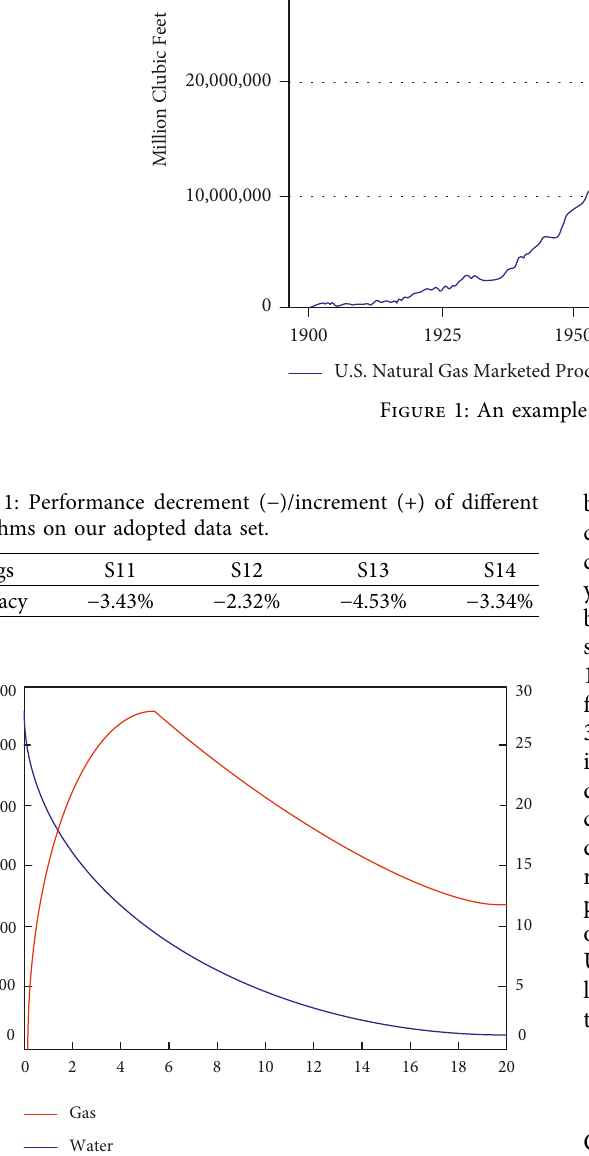
Figure 2: Typical CBM production profile